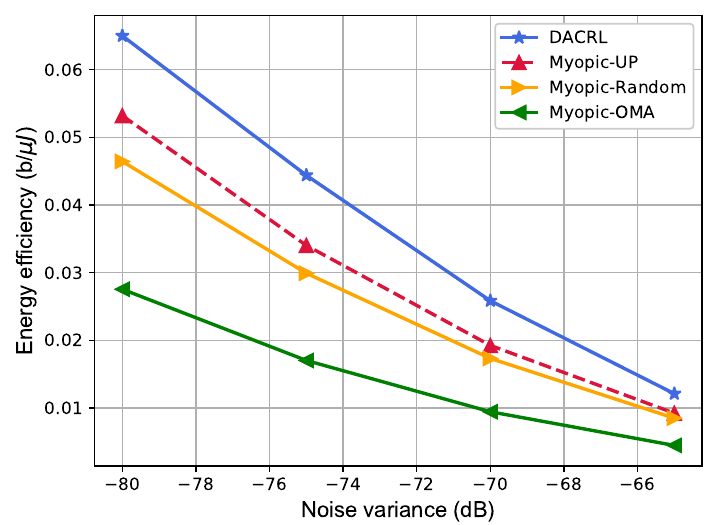
Figure 13. Energy efficiency according to noise